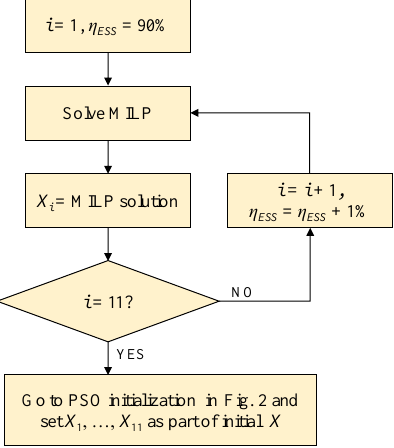
Figure 3. Flow chart of acquiring the initial points of PSO by using mixed-integer linear programming (MILP).